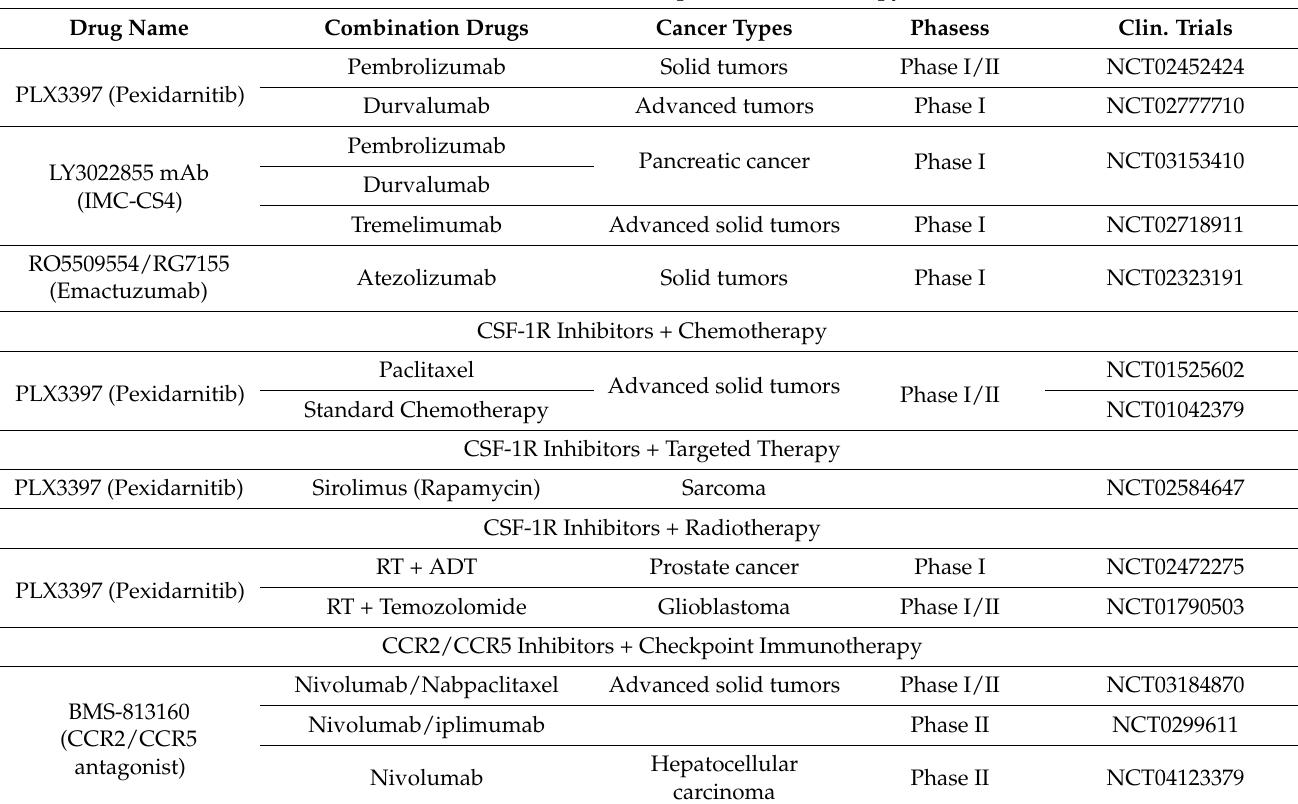
Selected clinical trials of the TAM-targeting agents in combination with other therapeutic